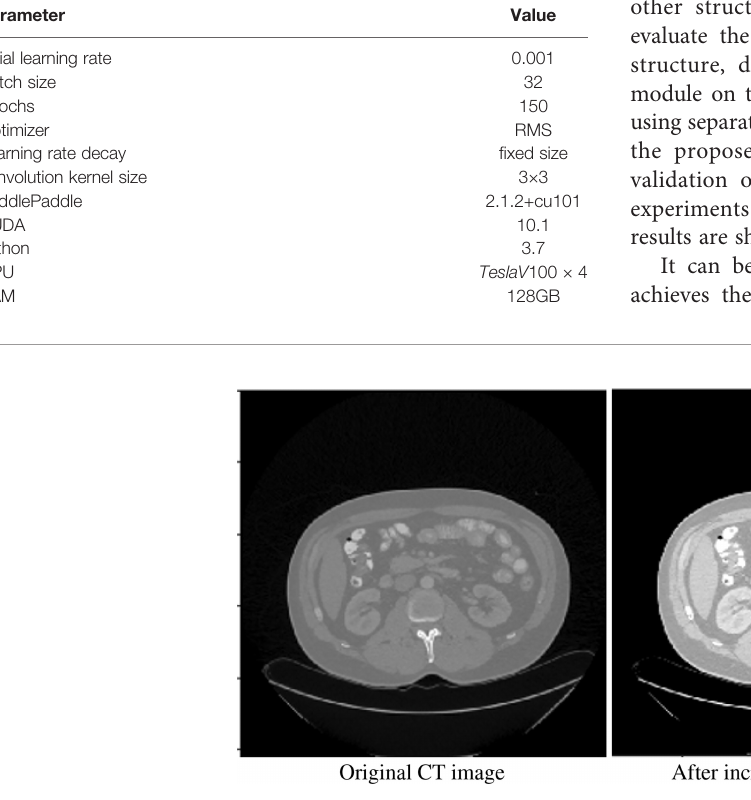
FIGURE 2 | Original image and contrast-enhanced